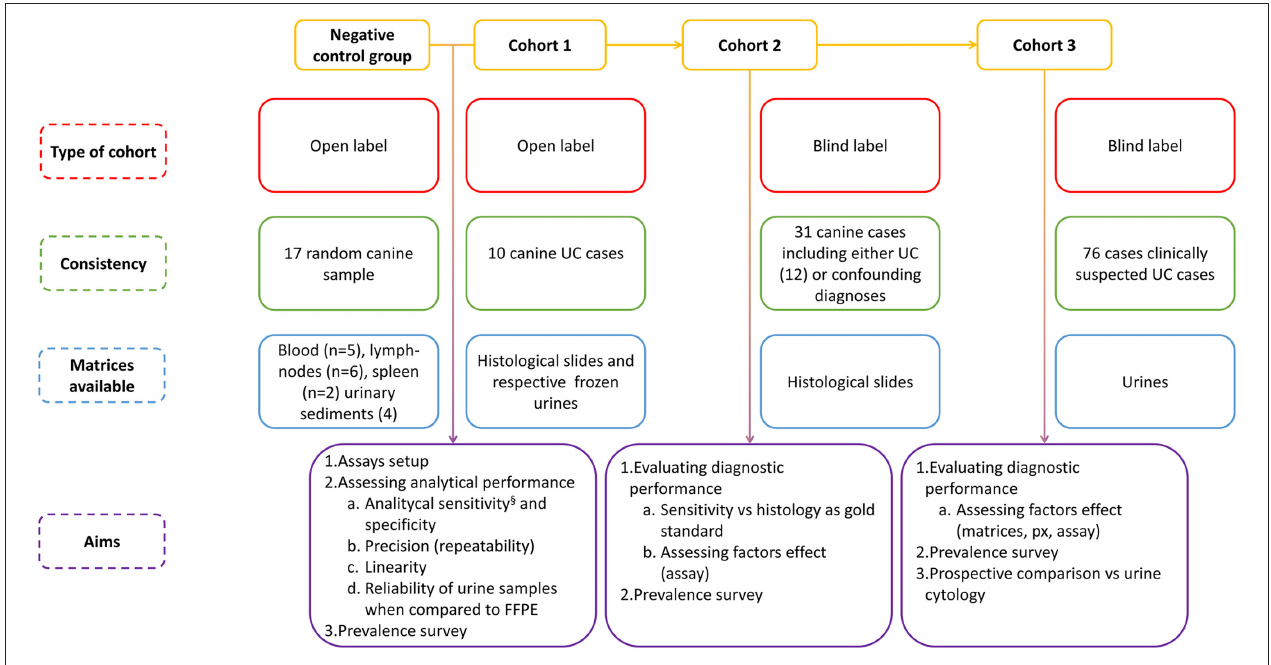
FIGURE 1 | Schematic representation of the experimental layout § which also includes samples from cohorts 2 and